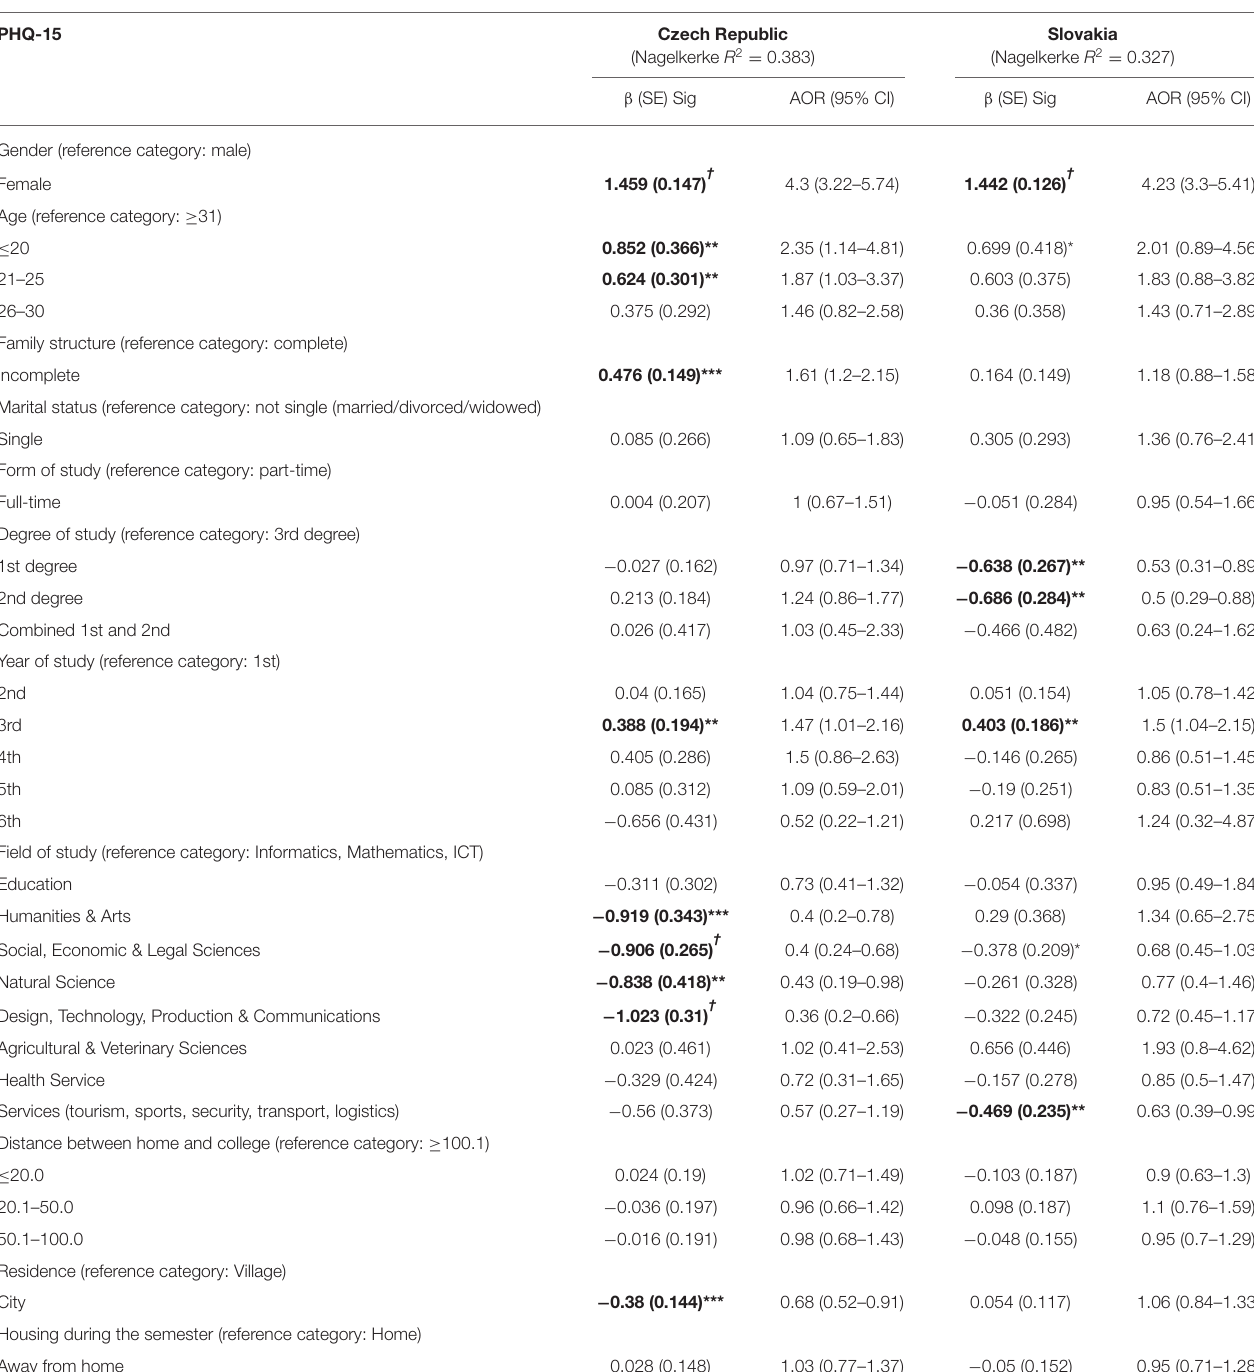
TABLE 3 | Logistic regression analysis with somatic symptoms (PHQ-15) as a dependent variable.